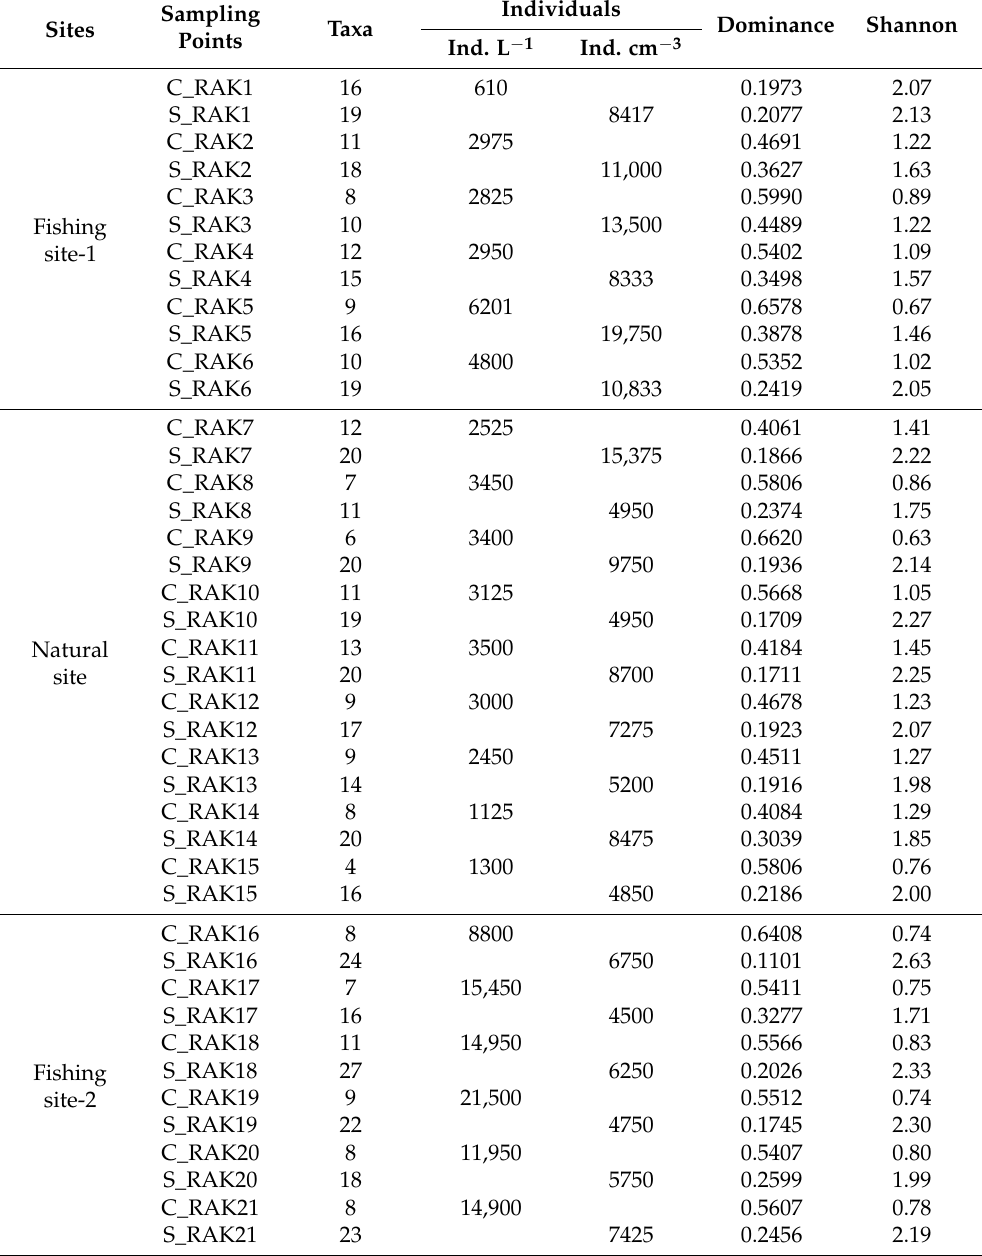
Table 2. Diversity indices of subfossil and contemporary Cladoceran assemblages in the oxbow lake (C: contemporary assemblage and S: subfossil